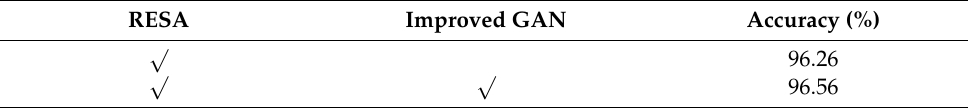
Table 4. Ablation studies of the constructed